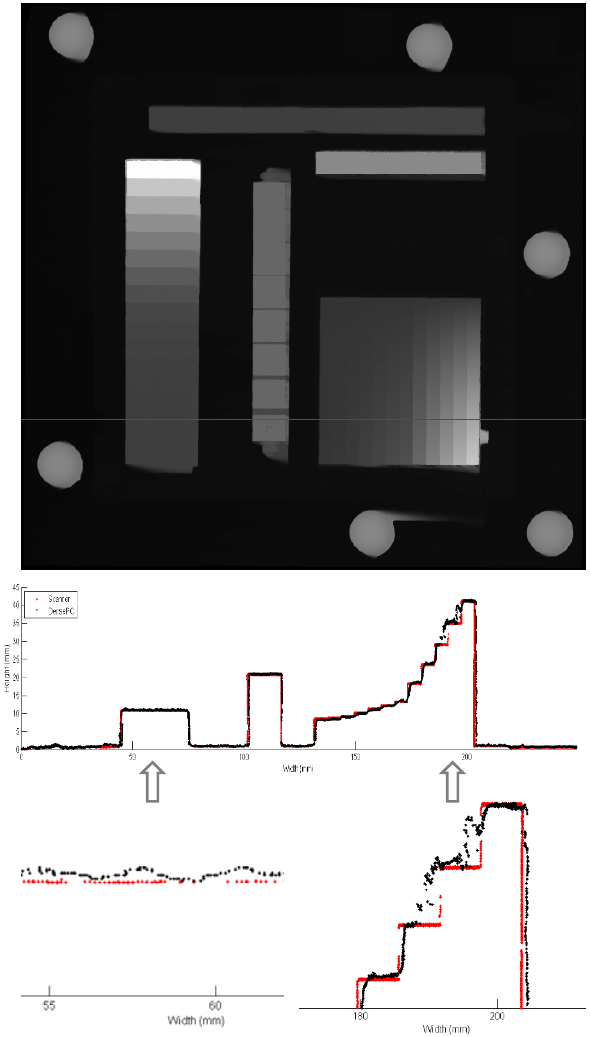
Figure 12. (top) DEM derived from top-down parallel projection (flattening) of scanner point cloud, represented as a grey-scale image; (middle) cross-sectional slices through point clouds from scanner (red) and dense image matching (black); (bottom) details of horizontal surface of staircase (left) and angle fan (right).